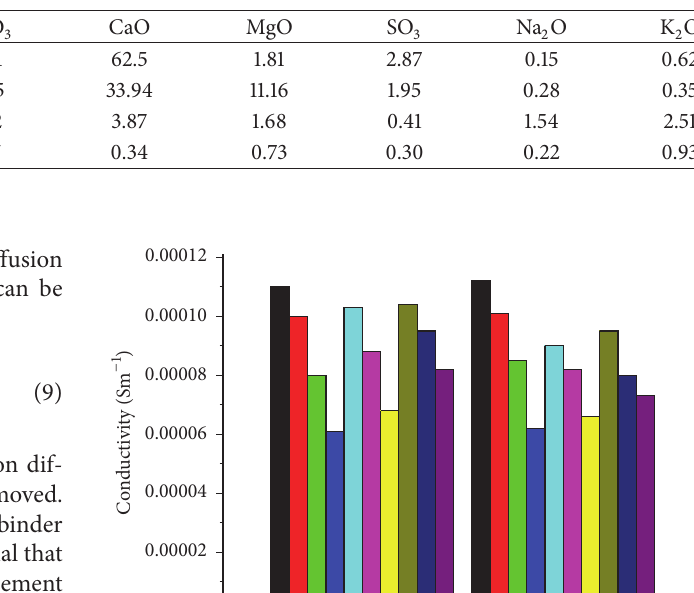
Table 1: Chemical compositions of cement and mineral admixtures (% by weight).